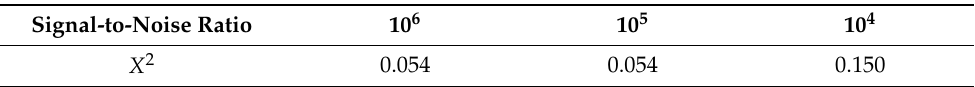
Table 3. Performance of the neural network model trained with noisy diffraction images, which has the SNR 10 5